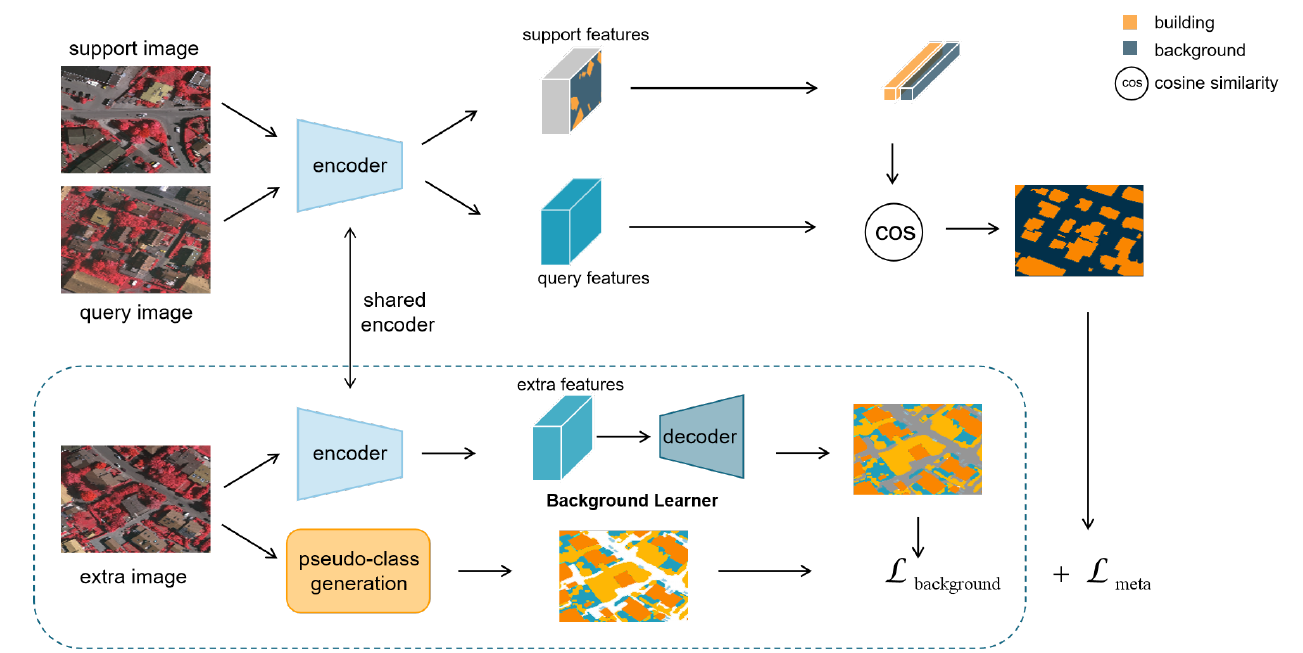
Figure 1. The main architecture of the presented framework. The dotted box is a self-supervised background learner (in Section 4.2), which mines latent classes in the background. The contrastive representation learning branch is described in Section